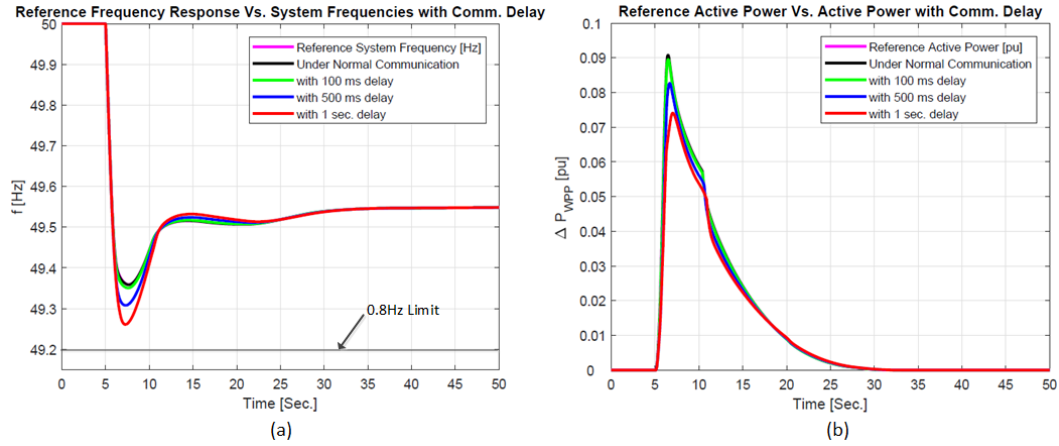
Figure 13. Figure showing at Full Load ( a ) System Frequency Response and ( b ) Total Active Power under different delay conditions compared to the Reference Frequency Response and Reference Active Power,